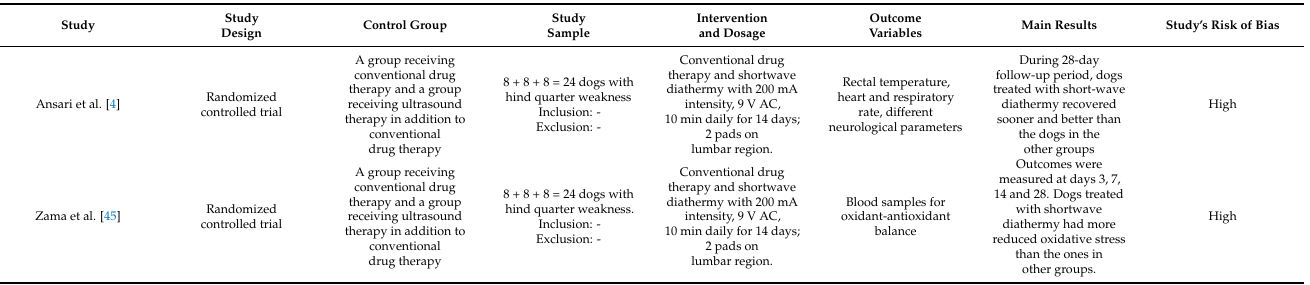
Table 9. Review of articles regarding